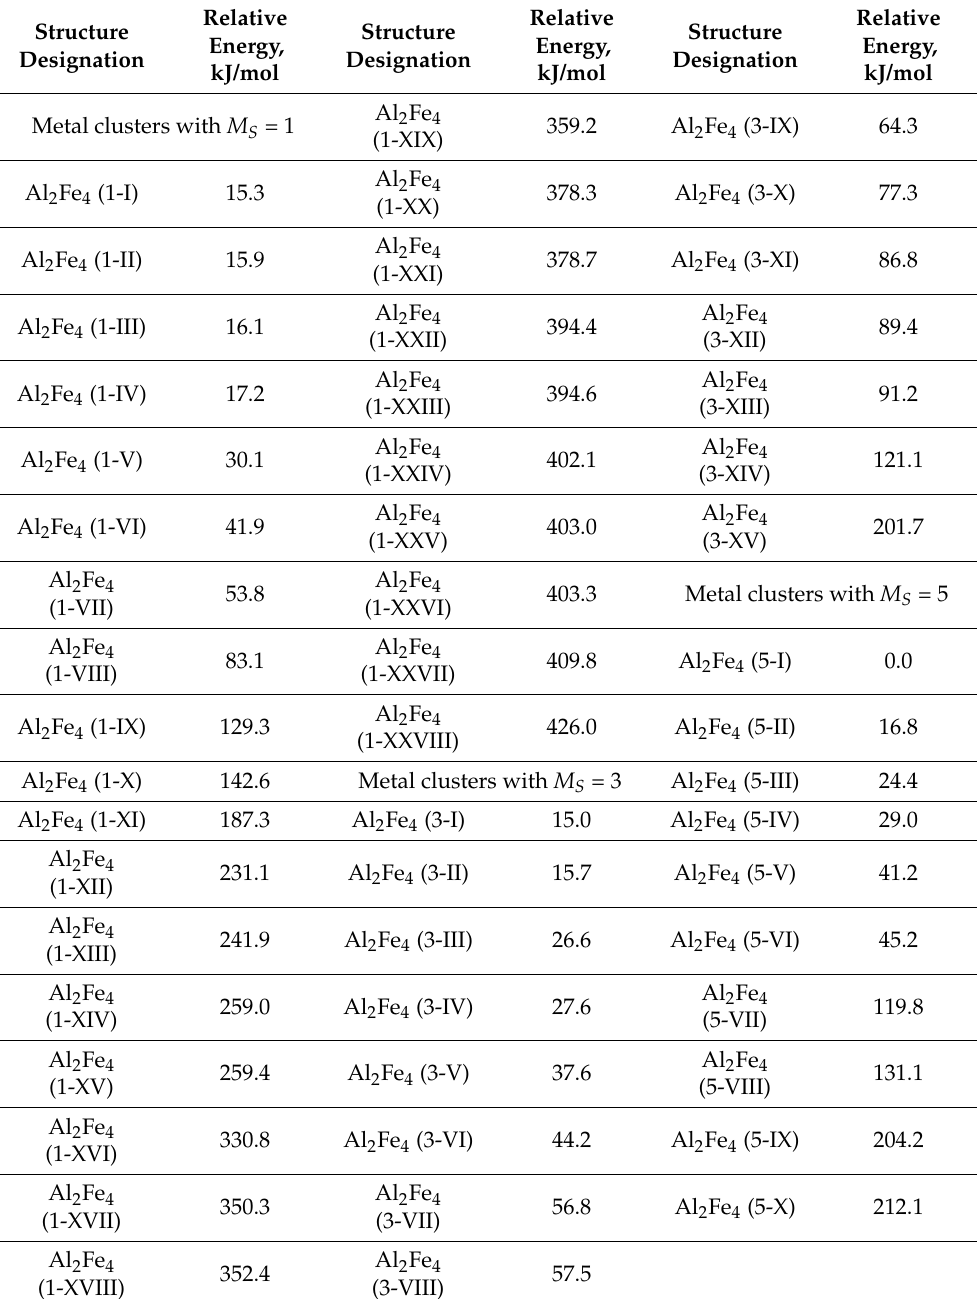
Table 7. Relative energies and spin multiplicities of the ground states of various structural isomers of metal clusters of Al 2 Fe 4